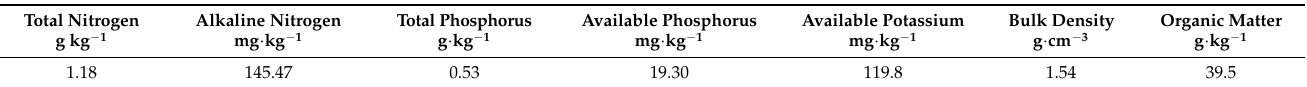
Table 1. The basic physical and chemical properties of